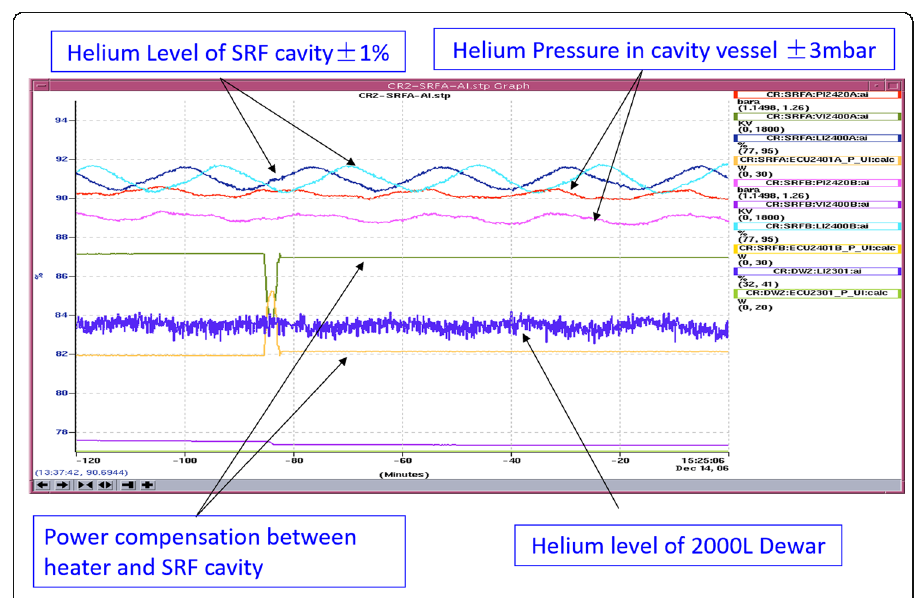
Fig. 14 Historical parametric curve during operation of SRF cavity cryogenic system